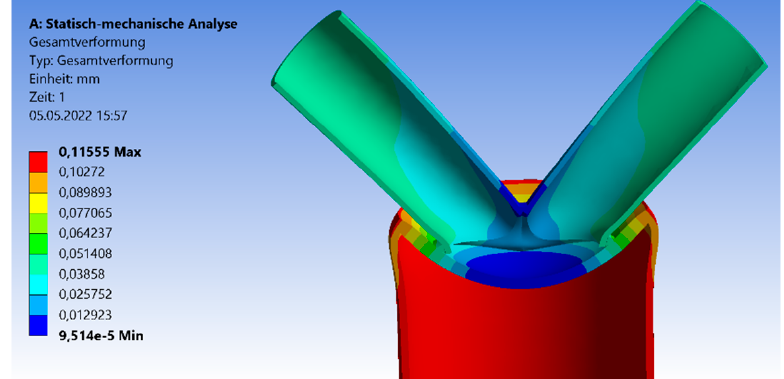
Figure 4. Deflection symmetrical 45° model—Section Cut.